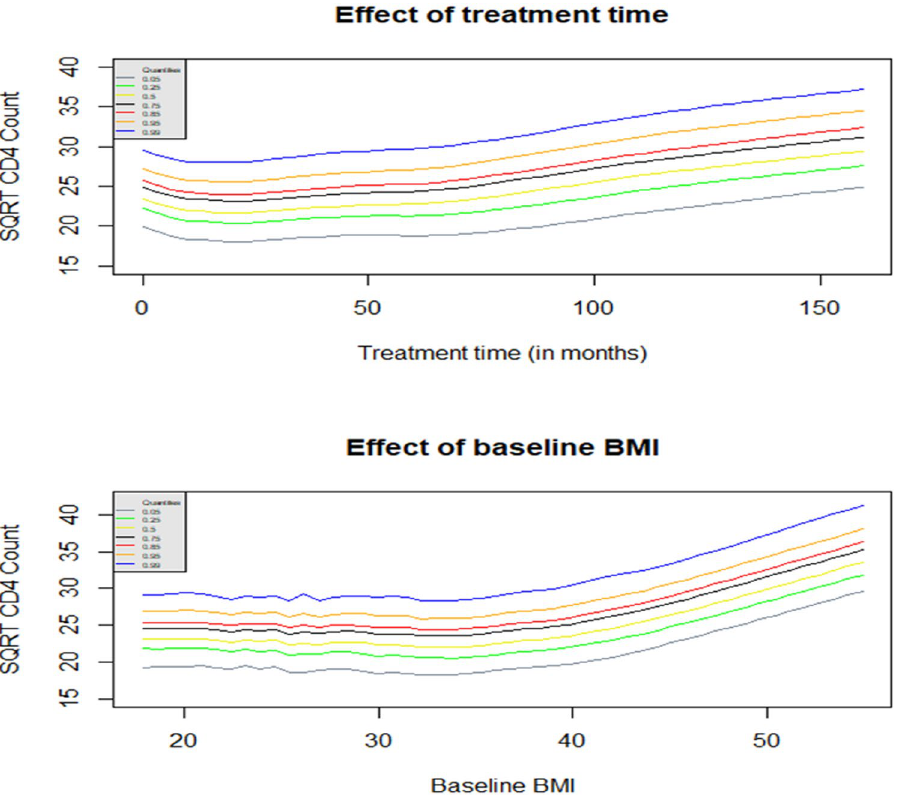
Figure 3. Predicted smoothed covariate effects on the square root CD4 count of HIV-infected patients recurred in the CAPRISA 002 AI study at various quantiles using